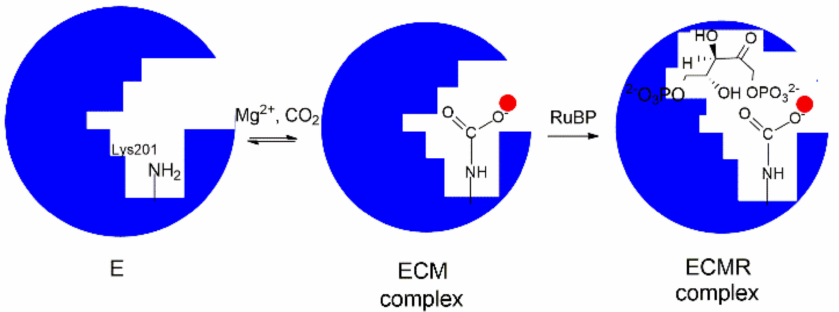
Figure 4. Schematic representation of the Rubisco “activation” and “catalytic” processes. E (repre- senting the unbound enzyme) react with CO 2 (C) and Mg 2+ (M) to form an active ternary complex (ECM) subsequently binding RuBP to give a quaternary ECMR complex. These events precede the carboxylation or oxygenation reaction (catalytic process) [29]. Previously unpublished